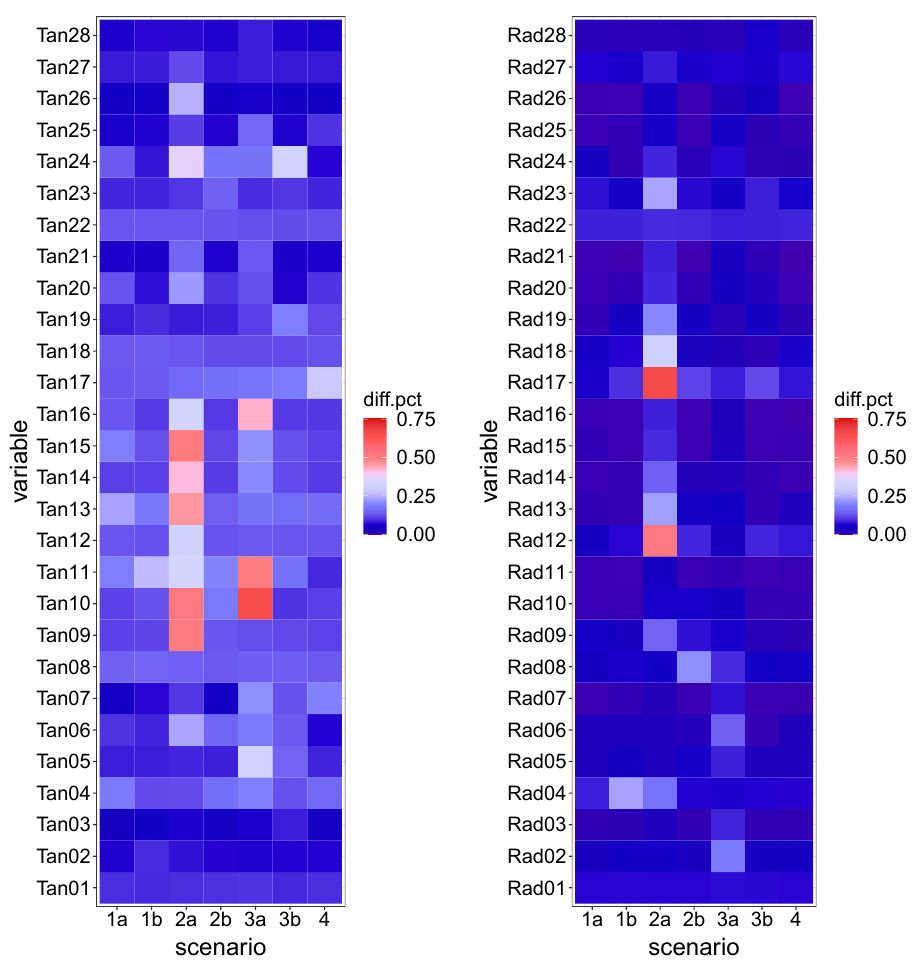
Figure 5. Median difference between anomaly scenarios and Scenario 0 for all tangential ( left ) and radial ( right ) displacements considered. Results are normalized to the range of variation of each input in Scenario